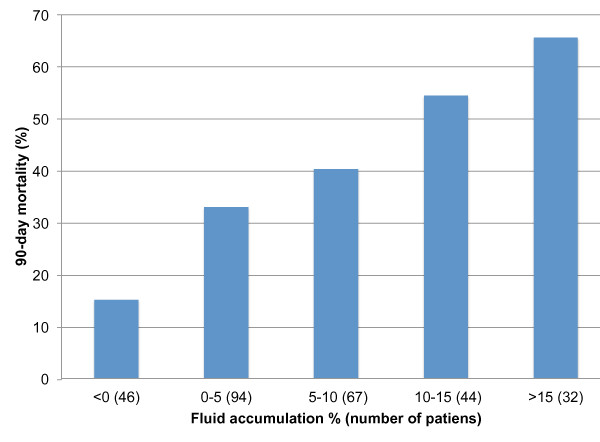
Ninety-day mortality according to the percentage of fluid accumulation prior to renal replacement therapy initiation. *Comparison across groups P < 0.001.